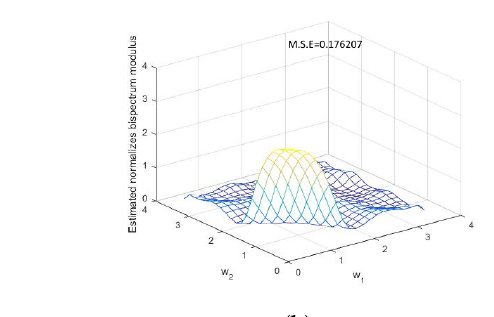
Figure 7. The estimated bispectrum modulus using Daniell window. ( a ) Generated observations. ( b ) Forecasted observations.